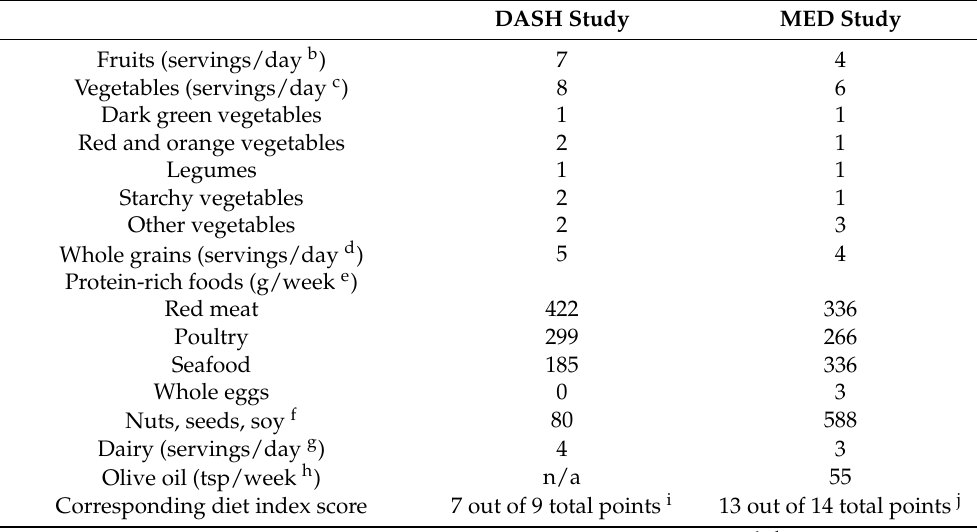
Table 1. Prescribed daily and weekly food group servings for the median energy intake level a . DASH Study MED